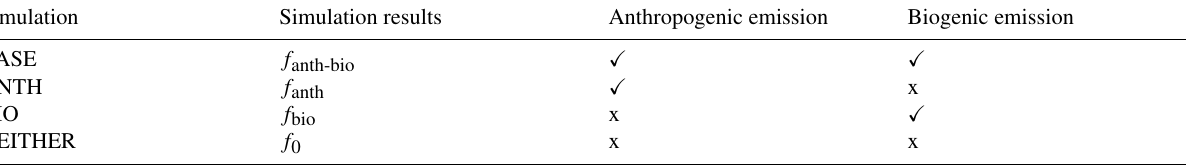
Table 2. Summary of different simulation settings and definitions of the various contributions from anthropogenic and/or biogenic sources.